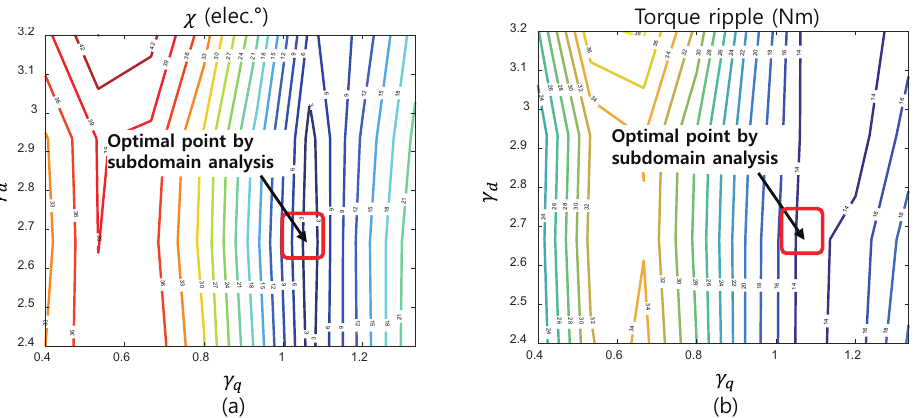
Figure 8. FEA optimization results when β = 0 with PM unmagnetized: ( a ) level plot of χ and ( b ) level plot of torque